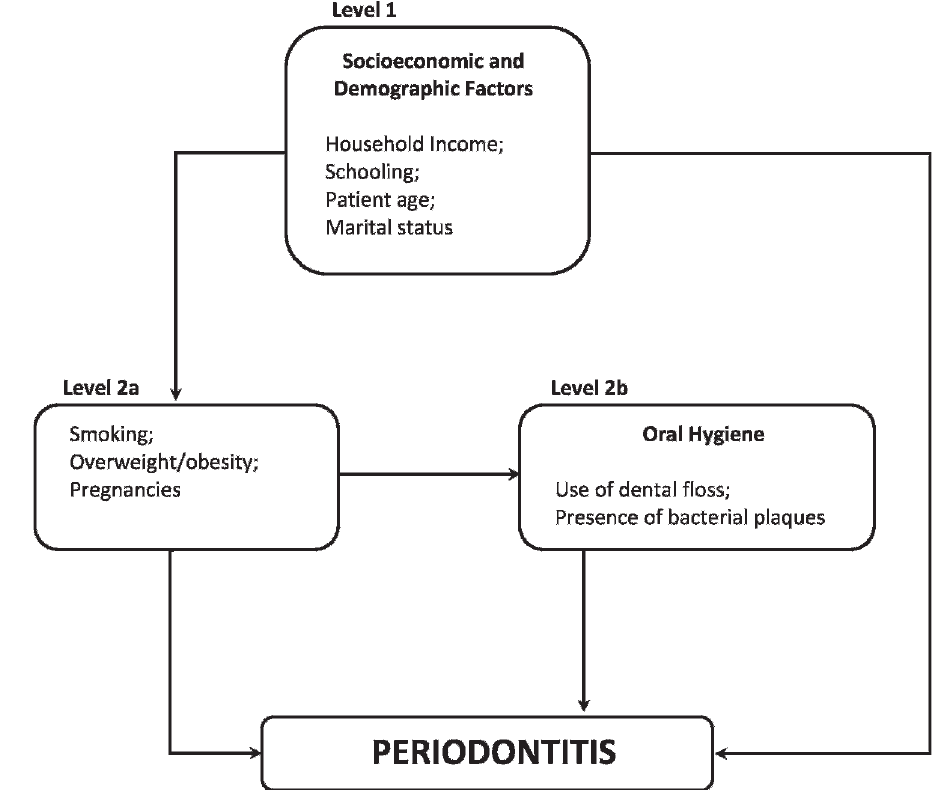
Figure 1 - Hierarchized model of risk factors for periodontitis in pregnant women, Recife, Brazil,